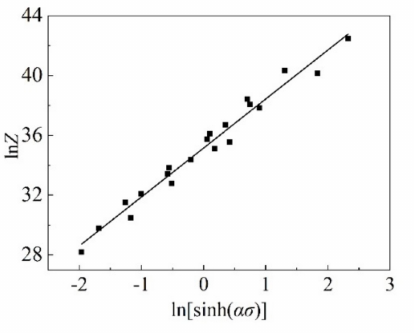
Figure 8. ln[sinh( ασ )]-lnZ diagram of Ti-6Mo-5V-3Al-2Fe alloy at strain